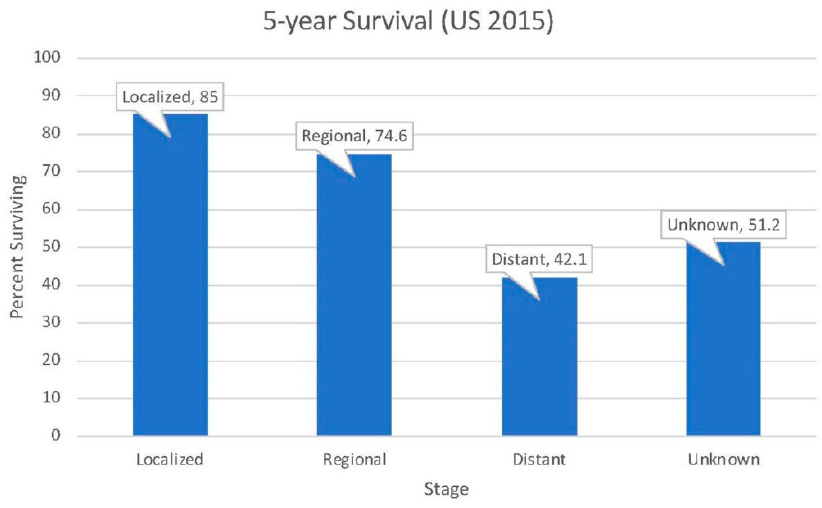
Figure 1. Five-year survival for neoplasms of the small intestine in the United States (data obtained from the Surveillance, Epidemiology, and End Results (SEER) database) .